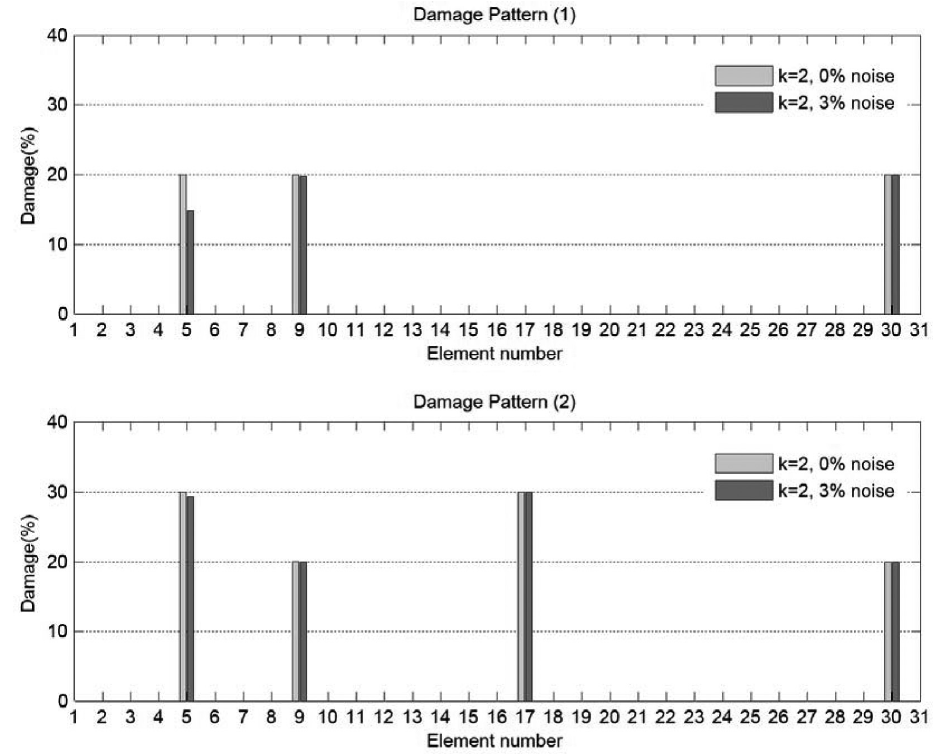
Fig. 10. Results of damage identi fi cation for two damage patterns of the plane steel